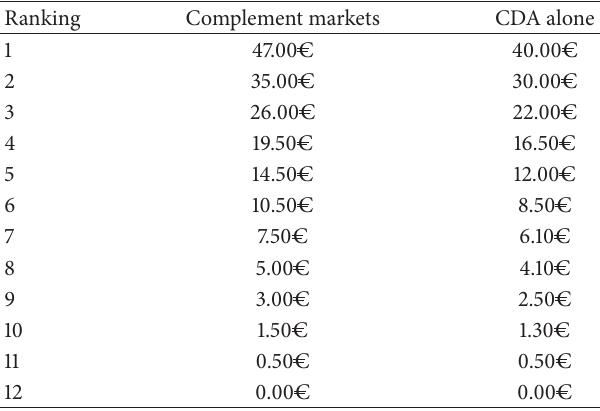
Table 1: Performance-dependent payout structure of the experi-